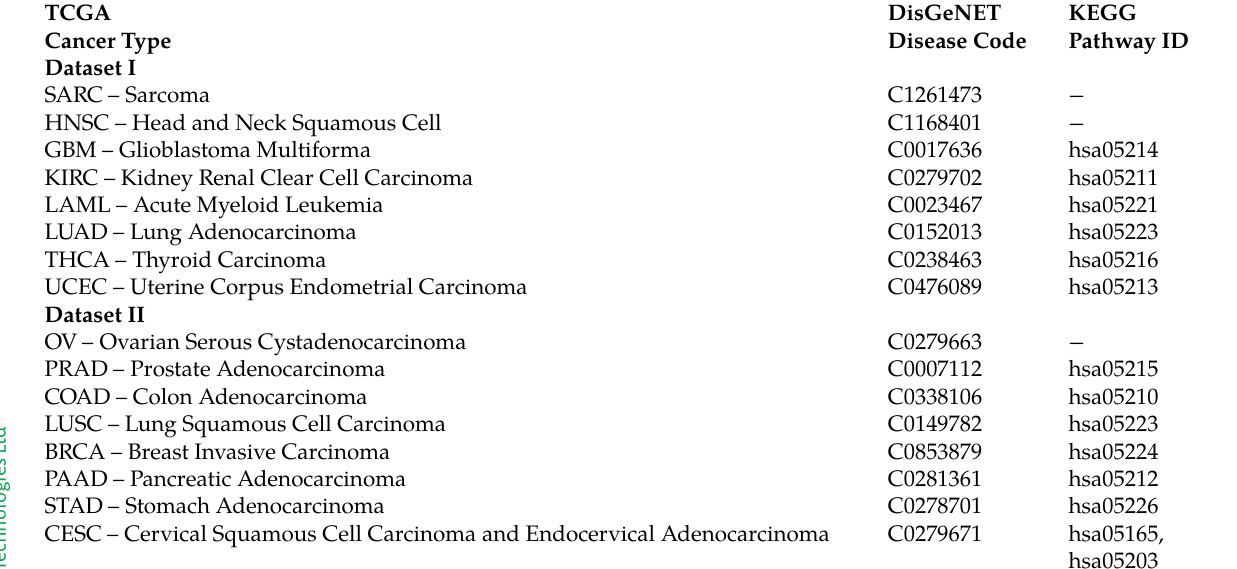
Table 2: Details on the two evaluation datasets and their corresponding cancer types, DisGeNET disease codes, and KEGG pathway